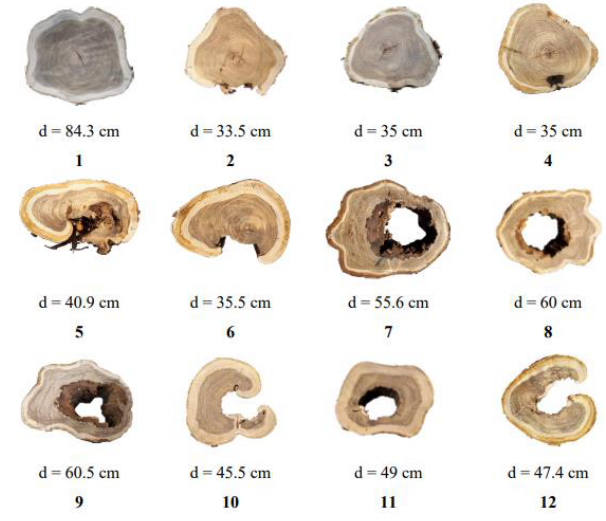
Figure 2. Cross-sections from the trees of Cenostigma pluviosum (Sibipiruna). d = larger diameter.